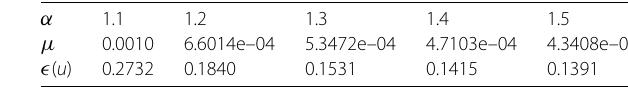
Table 2 At t = 0: θ = 0, s = 2, γ = 0.2, ε = 0.01, the relative errors for various α